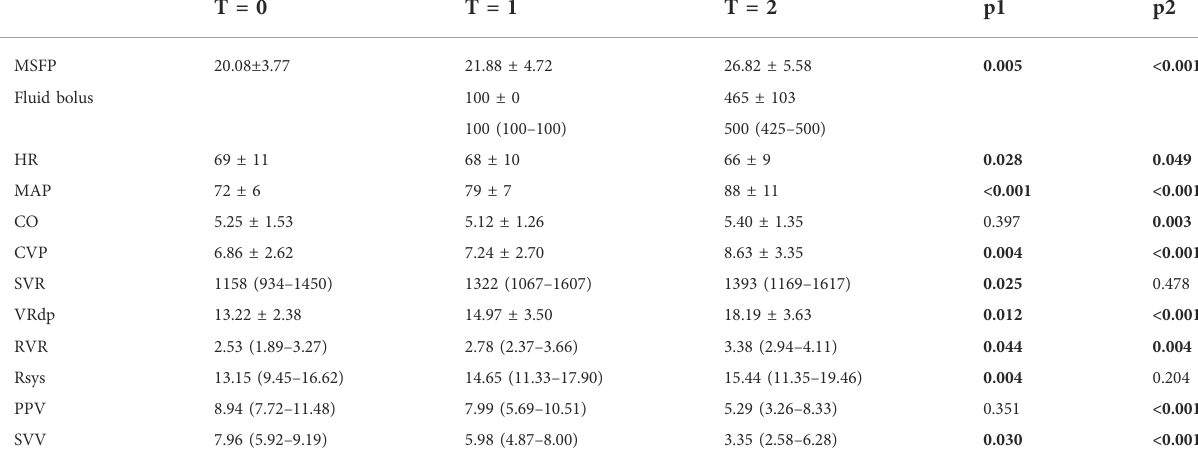
TABLE 2 Hemodynamic changes after two fl uid